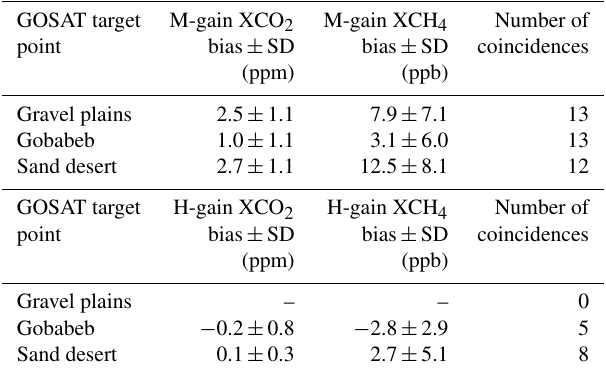
Table 4. This table presents the results of the comparison between the COCCON station in Namibia and the assimilated CAMS model data. Bias and SD are given as the mean difference and 1 standard deviation between the coincident hourly pooled local noon COC- CON and CAMS XCO 2 and XCH 4